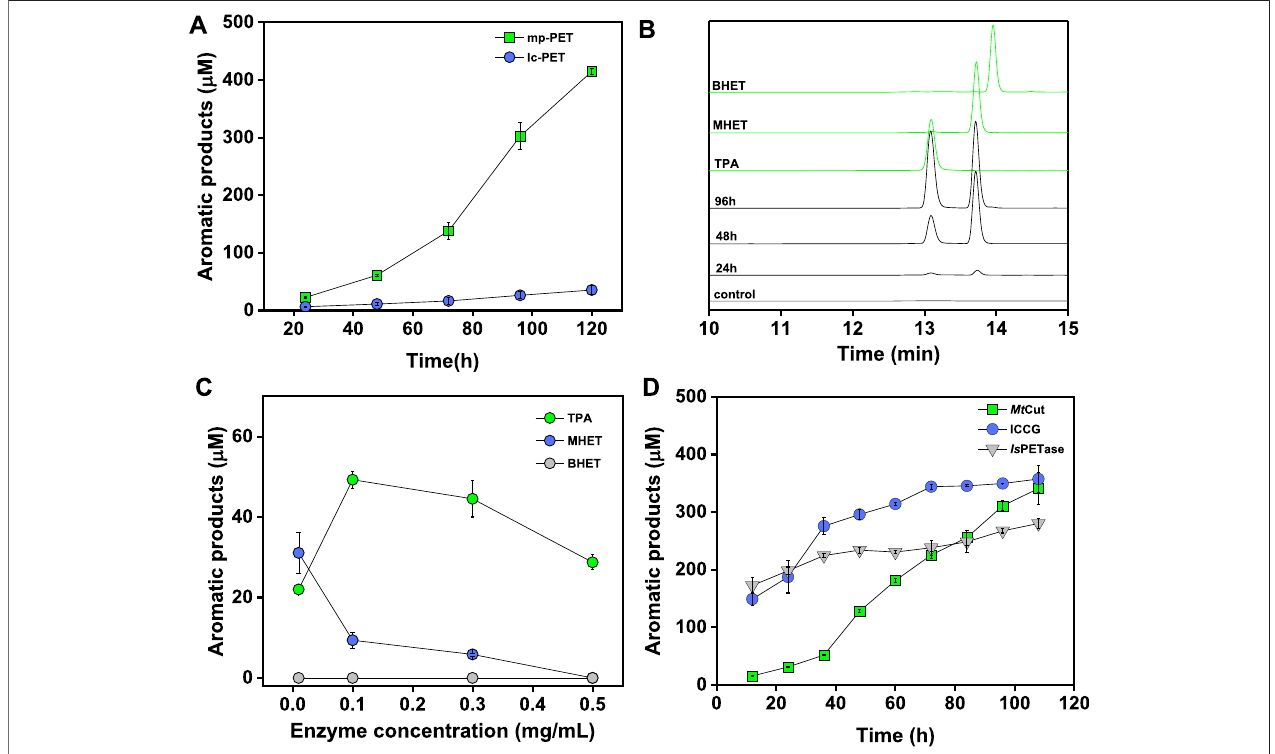
FIGURE 3 | PET hydrolysis by Mt Cut. Released aromatic products were quanti fi ed as the sum of detected compounds (TPA, MHET, and BHET). (A) Progress curves showing variations in total aromatic product release over time toward micro-particle PET (mp-PET) and low crystallinity PET fi lm (lc-PET). (B) High performance